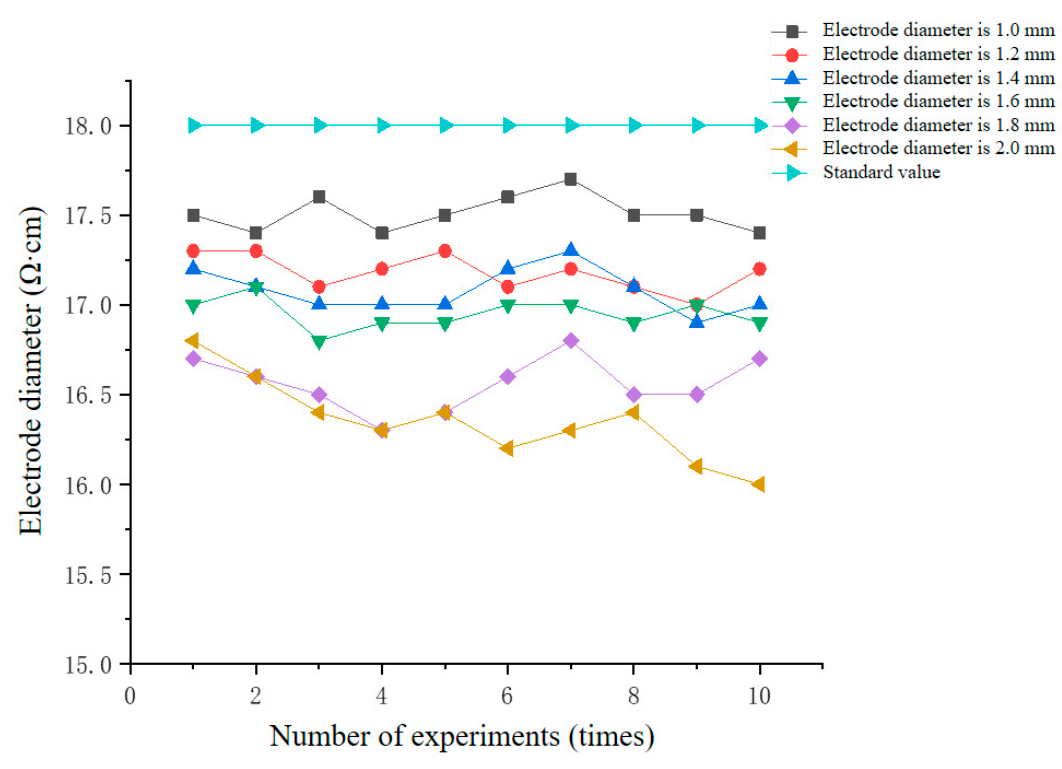
Figure 18. Experimental plot of distilled water with equal electrode diameter and different electrode length.